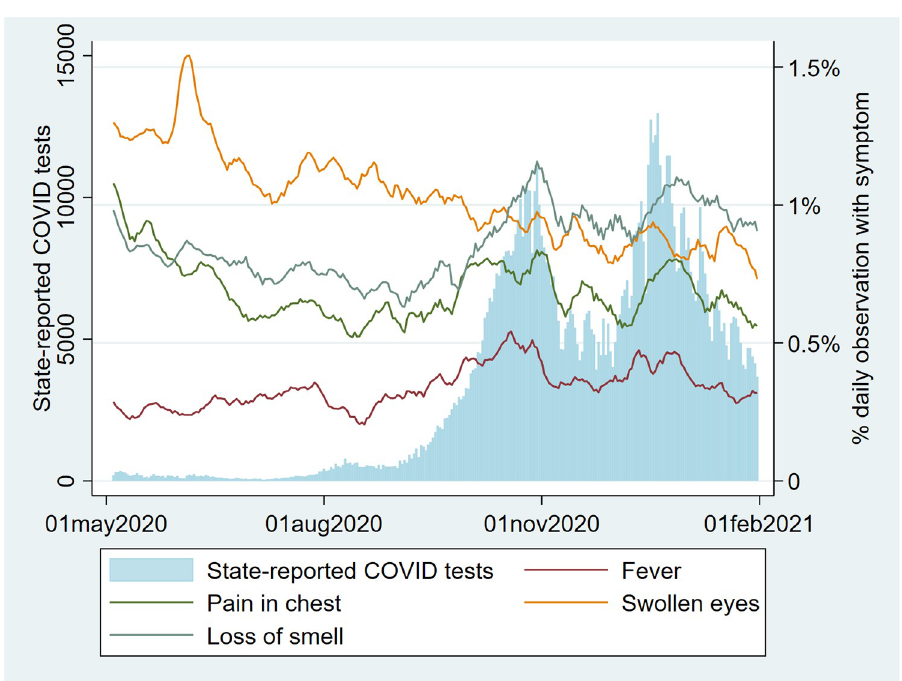
Fig 9. Symptoms vs. time alongside number of nationally reported positive SARS-CoV-2 tests (percentage of users reporting pain in chest, fever, loss of smell, swollen eyes).